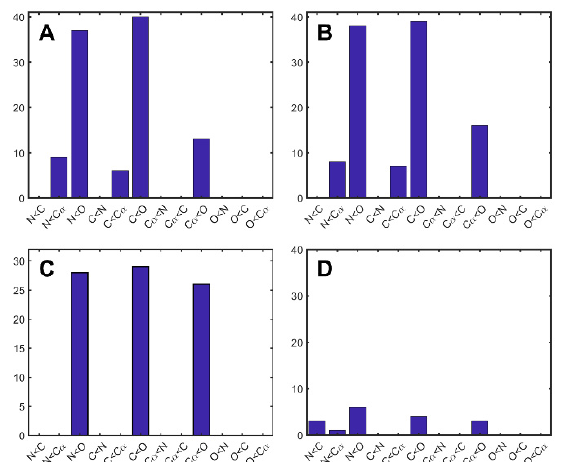
Figure 3. Results of Friedman’s Test and subsequent multiple comparisons analysis. A bar, associated with a comparison X < Y, that is n units high, indicates that, in n structures, the assessed measure of coordinate variability is significantly lower for atom type X than for atom type Y. e.g., in panel A, the bar associated with C < O being 39 units high indicates that in 39 NMR ensembles, the coordinate uncertainties (calculated using FindCore superimpositions) for carbonyl carbons are significantly less (according to Friedman’s test) than those for carbonyl oxygens. Mean ranks are considered significantly different if they differ by more than three standard deviations. Assessed measures of coordinate variability are ( A ) coordinate uncertainties in FindCore superimposed NMR ensembles, ( B ) coordinate uncertainties in THESEUS superimposed NMR ensembles, ( C ) coordinate uncertainties in THESEUS superimposed MD trajectories, and ( D ) crystallographic B-factors. Note that, in almost all superimposed NMR ensembles (independent of superimposition method), as well as in almost all THESEUS superimposed MD trajectories, amide nitrogen and carbonyl carbons have significantly lower coordinate uncertainties than carbonyl oxygens. However, only a small number of crystallographic structures have any significant results using the Friedman’s test to compare B-factors of different atom types.